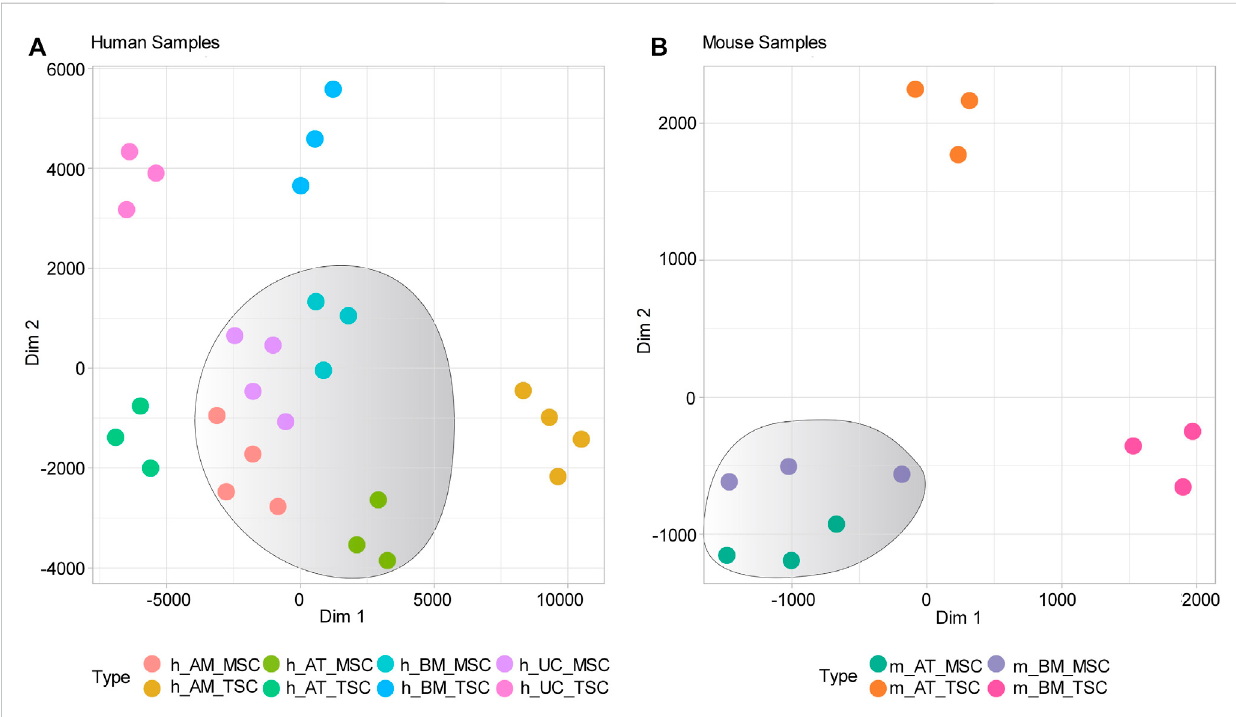
FIGURE 1 Geneexpression-based clustering ofMSCs samplesincluded in thestudy. (A) and (B) t-SNEclustering shows distinct clusters for human and Mouse MSCs,